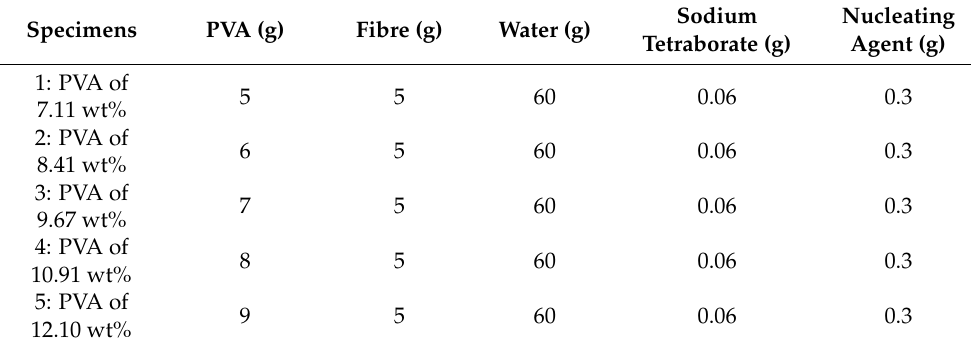
Table 1. Formulations of composites with different PVA contents.